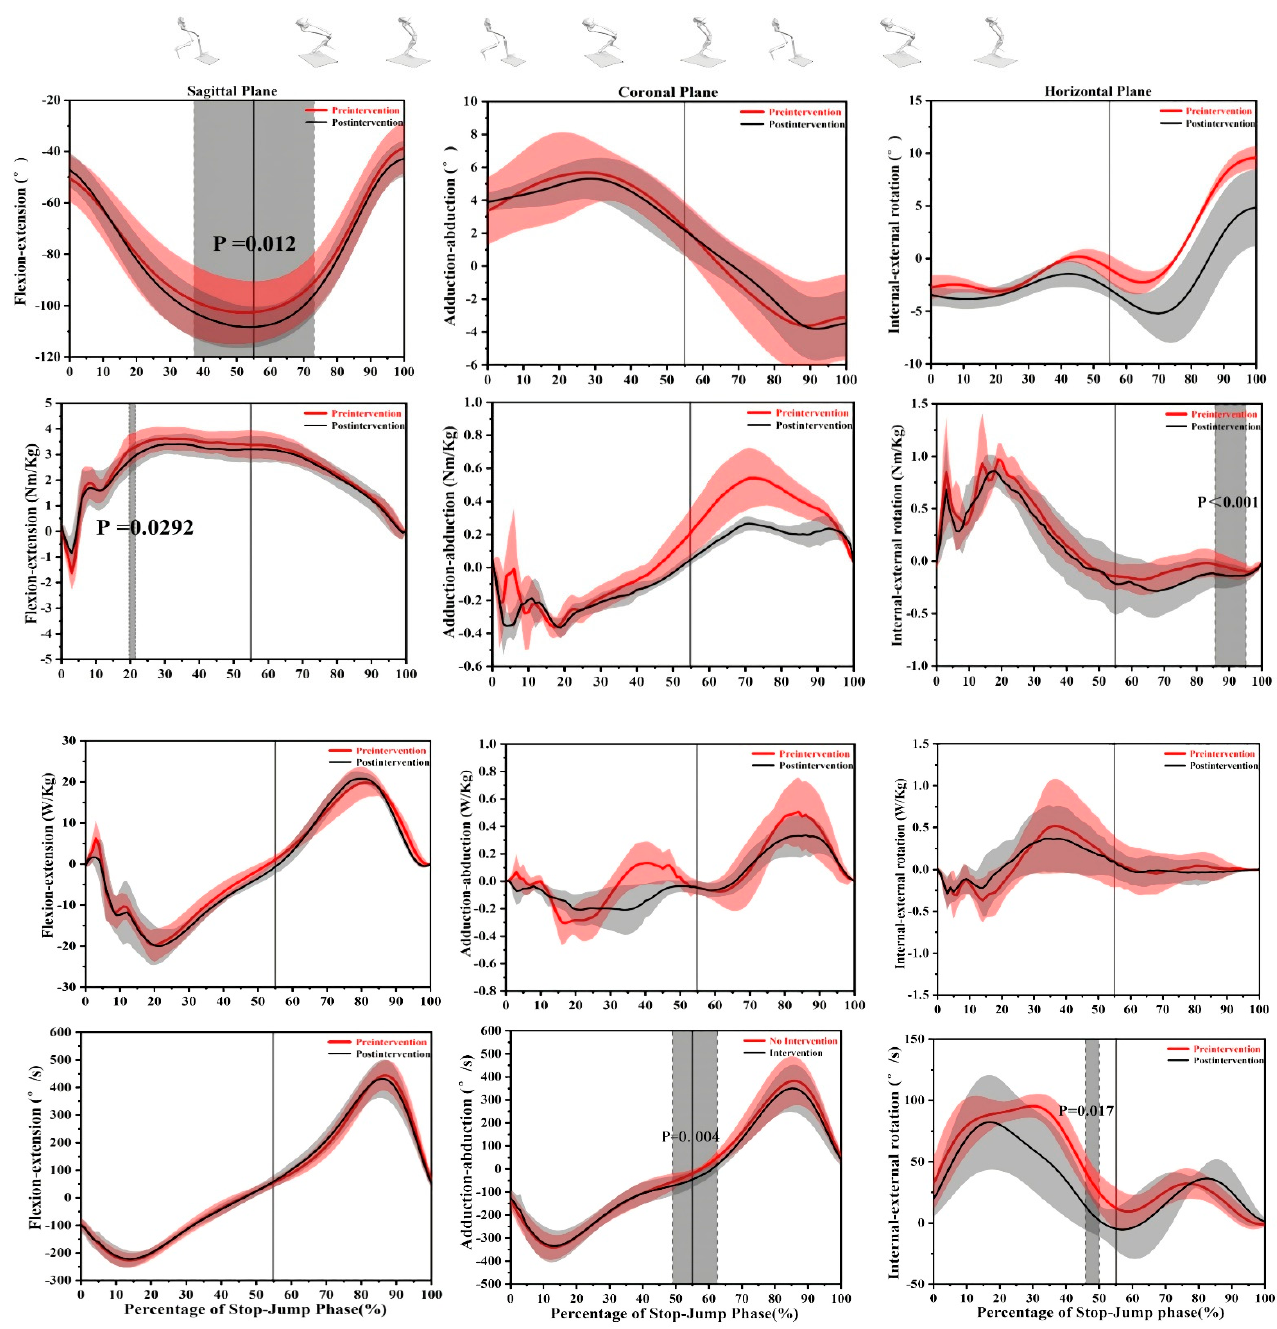
Figure 3. The results of statistical parametric mapping (SPM) pre- and post-video feedback depicting the mean angle, moment, power and angular velocity with a standard error in the knee sagittal, coronal and transverse planes. The solid line at 55% represents the time of maximum knee flexion. The grey region indicates a statistical difference ( p < 0.05). Table 1. The results of the vGRF. A larger knee flexion angle was found after feedback during the phase from